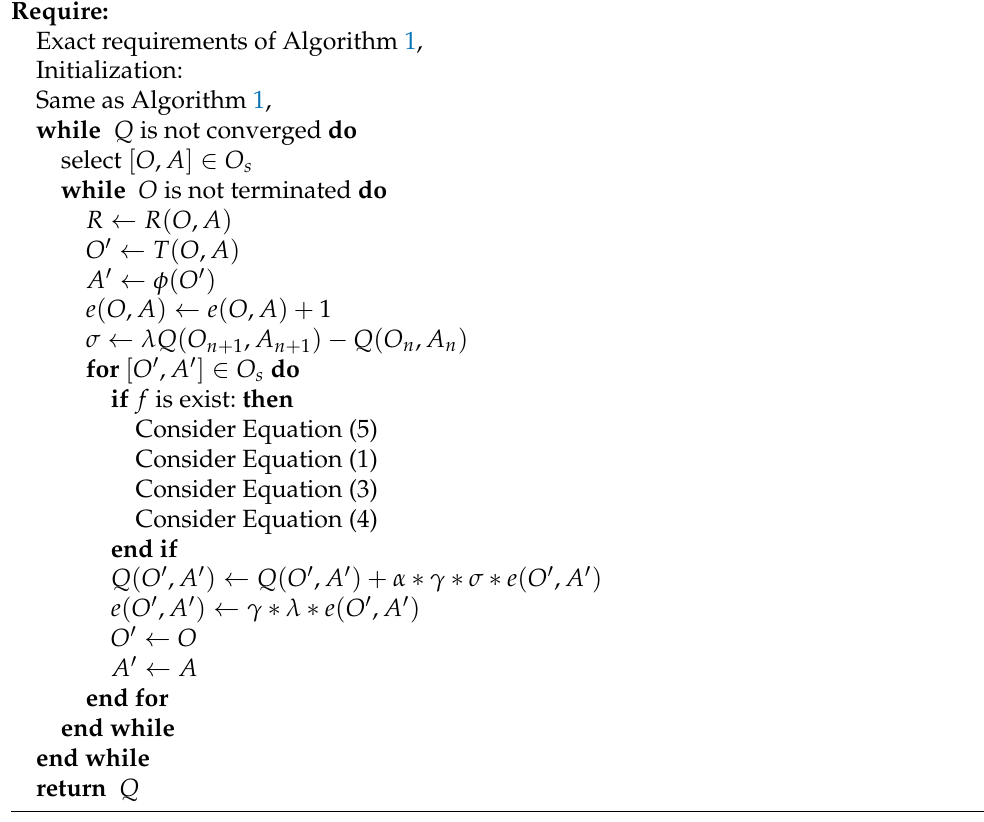
Algorithm 4 Hybrid Asynchronous Advantage Actor-Critic Agents Imitation